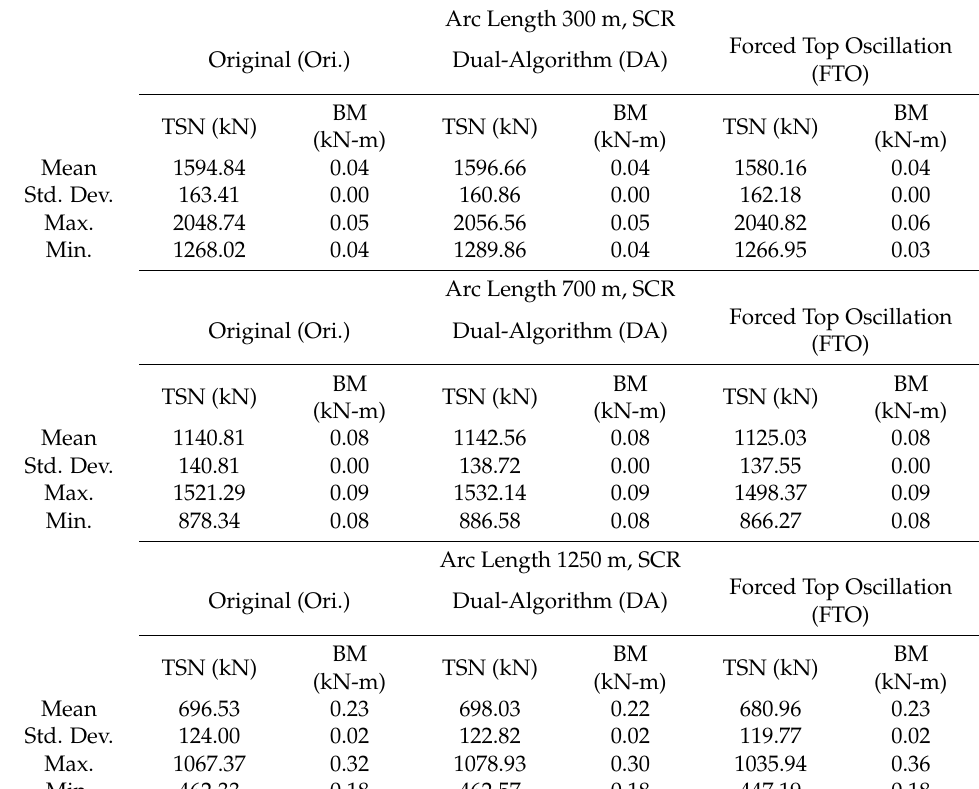
Table A1. Statistical Characteristics Comparison, Original vs. Dual-Algorithm (DA) or FTO, 100-yr storm, WD1000, SCR.